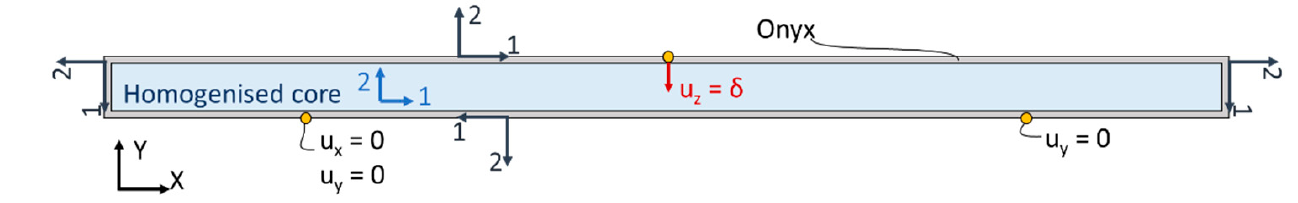
Figure 4. Two-dimensional 3PB simulations with a 160 mm span length. Axes 1–2 indicate local orientation.